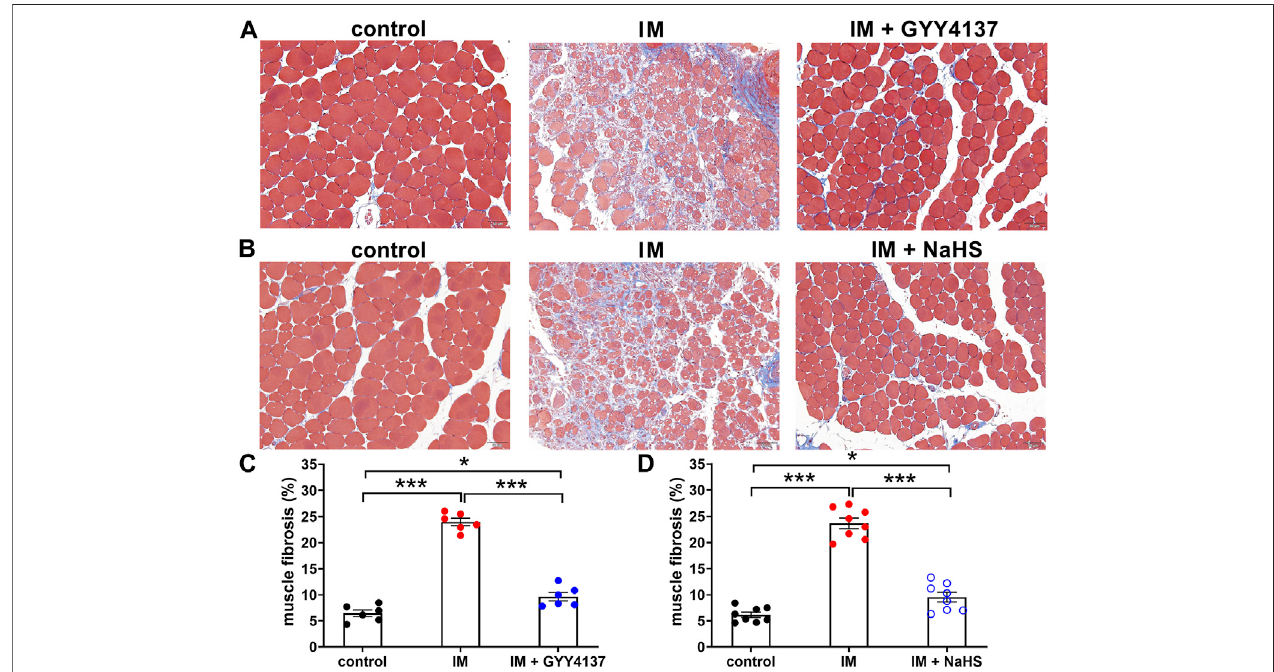
FIGURE3| H2S donors reduce theIM-induced muscle fi brosis. Mice weresubjectedtoIMand treatedwithGYY4137(a andc,50 μ g/kg/d, ip),or NaHS(band d, 1.12 mg/kg, twice a day, ip) for 2 weeks. The control and IM groups received identical doses of saline for 2 weeks. (A) and (B) , Representative photomicrographs of Masson-stained TA muscles (scale bars, 50 μ m). (C) , Quanti fi cation of the fi brosis fraction of TA muscles in control, IM, and IM + GYY4137 mice (n = 6 in each group). (D) , Quanti fi cation of the fi brosis fraction of TA muscles in control, IM, and IM + NaHS mice (n = 8 in each group). Data represent means ± SEM. * p < 0.05, ** p < 0.01, *** p < 0.001.